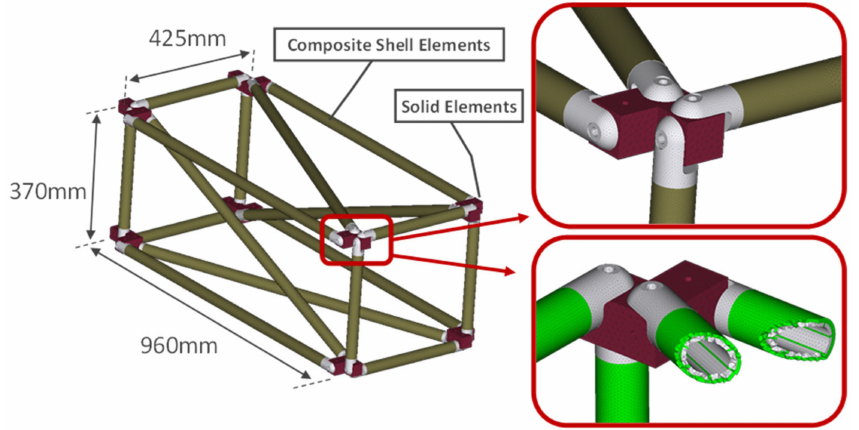
Figure 4. Finite Element model of the